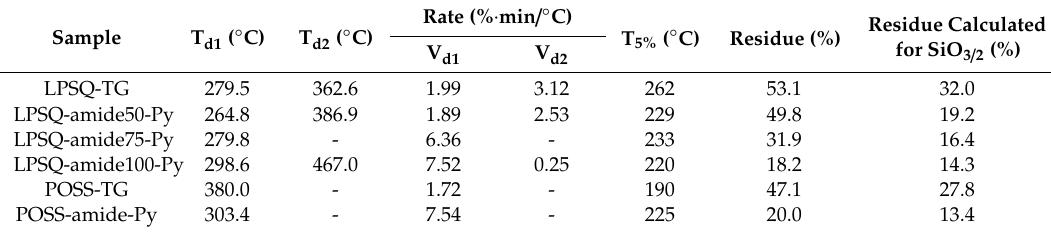
Table 2. The parameters of thermal degradation of LPSQ and POSS-amide-Py and their